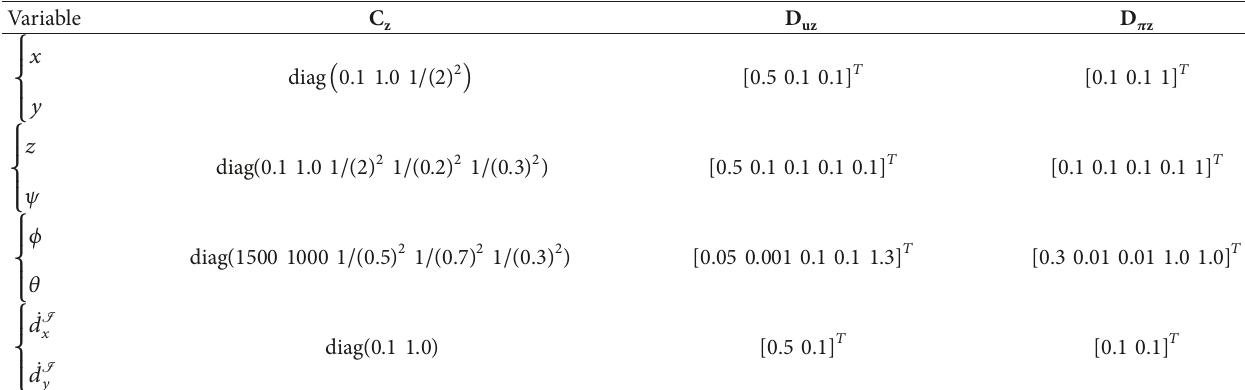
Table 3: Weighting matrices of H 2 and H ∞ norms for the NLLS-2L controller.